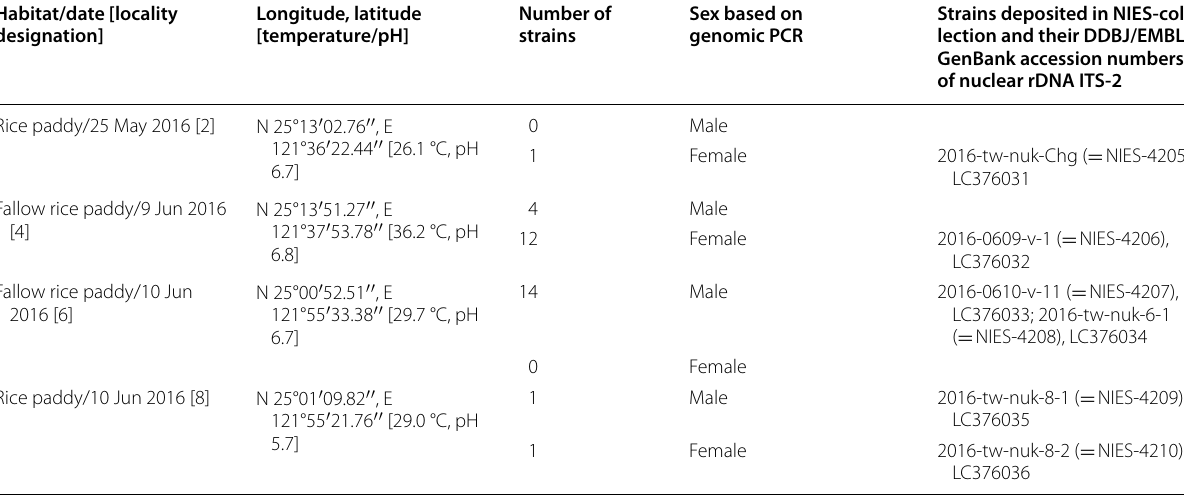
Table 1 List of Taiwanese strains of Volvox carteri f.